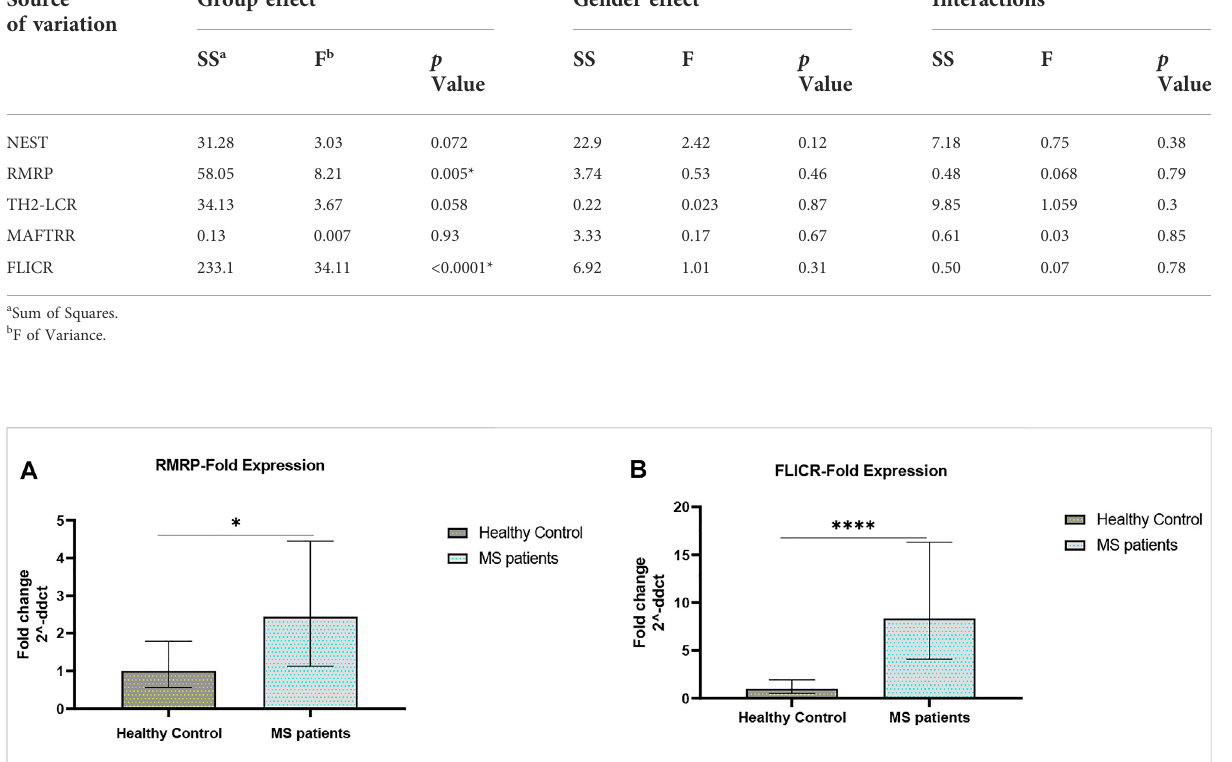
FIGURE 2 Fold changes of RMRP and FLICR expression (A,B) in MS patients versus healthy controls ( p p value < 0.05, and pppp p value <